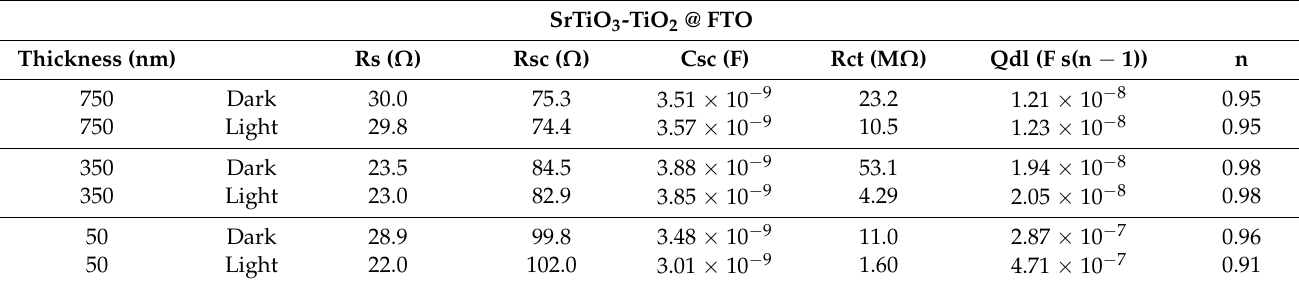
Table 2. The fitting results of the experimental data for the proposed equivalent-circuit model for SrTiO 3 -TiO 2 layers sputtered on Ti substrate and FTO substrate under dark and light conditions: where Rs is series resistance, Rsc is space charge resistance, Csc is space charge capacitance, Rct is charge transfer resistance, Qdl is electrode capacitance in constant phase element, and n is constant phase exponent. SrTiO 3 -TiO 2 @